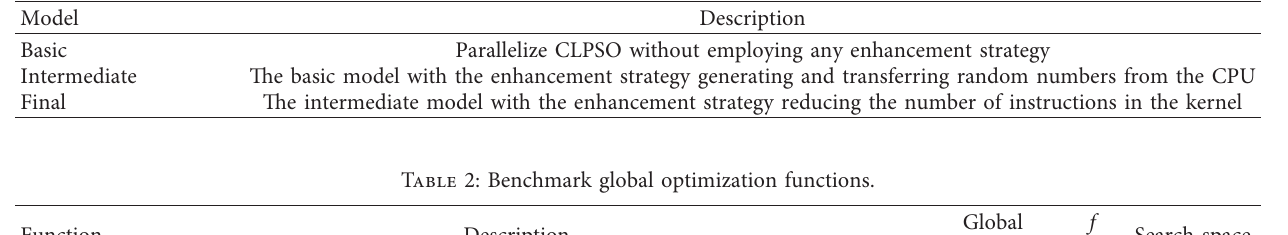
Table 1: Coarse-grained all-GPU models of CLPSO.